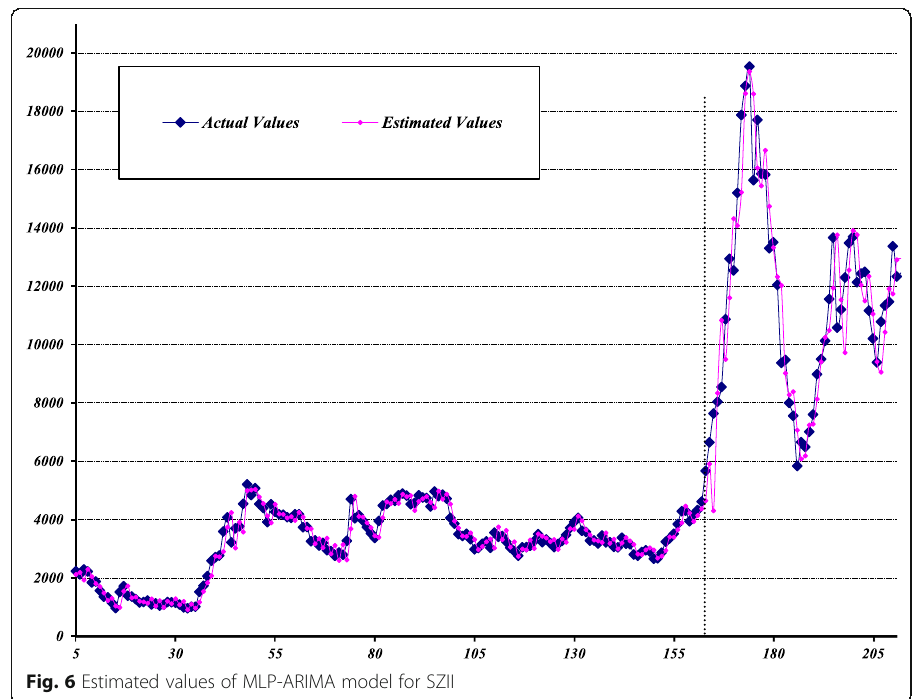
Fig. 6 Estimated values of MLP-ARIMA model for